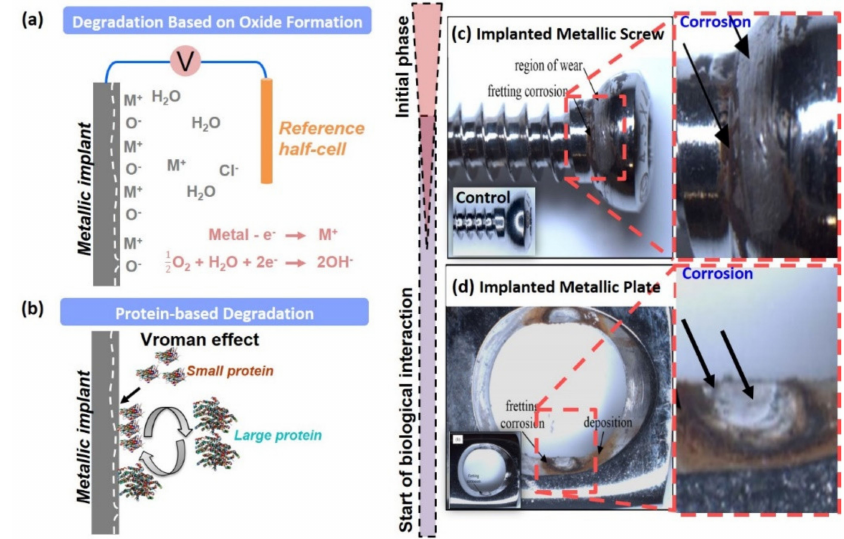
Figure 2. Mechanism of metallic bioimplant degradation ( a , b ) [15,16] and fretting corrosion tests